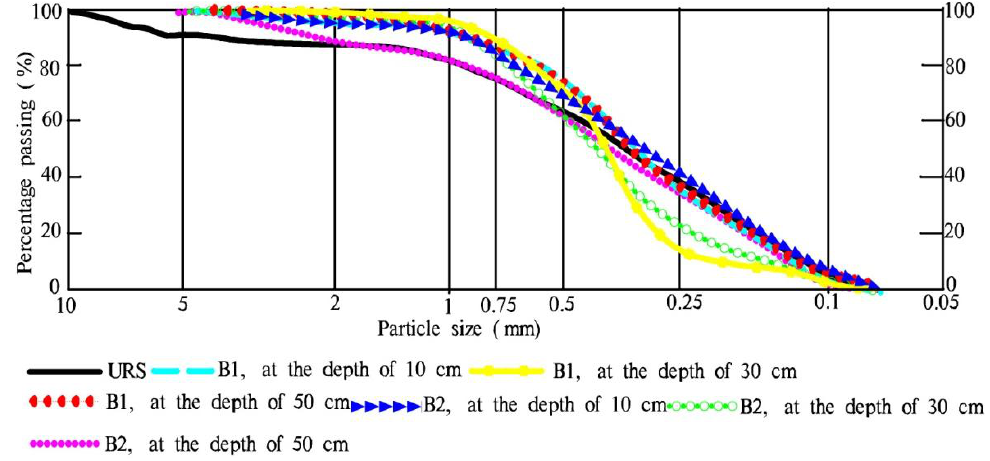
Figure 12. Accumulative curve of particle gradation of soil with overlaying soil thickness of 50 cm (B1 and B2).